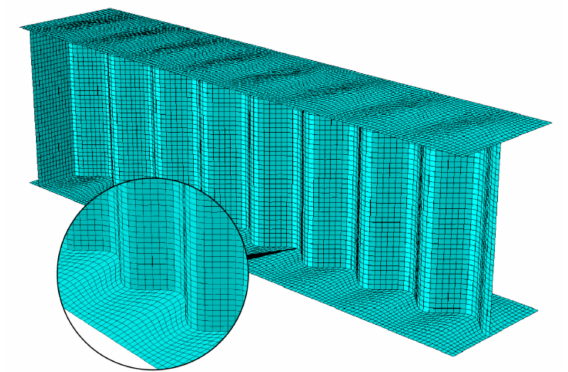
Figure 4. The finite element grid of the I-beam with corrugated web.